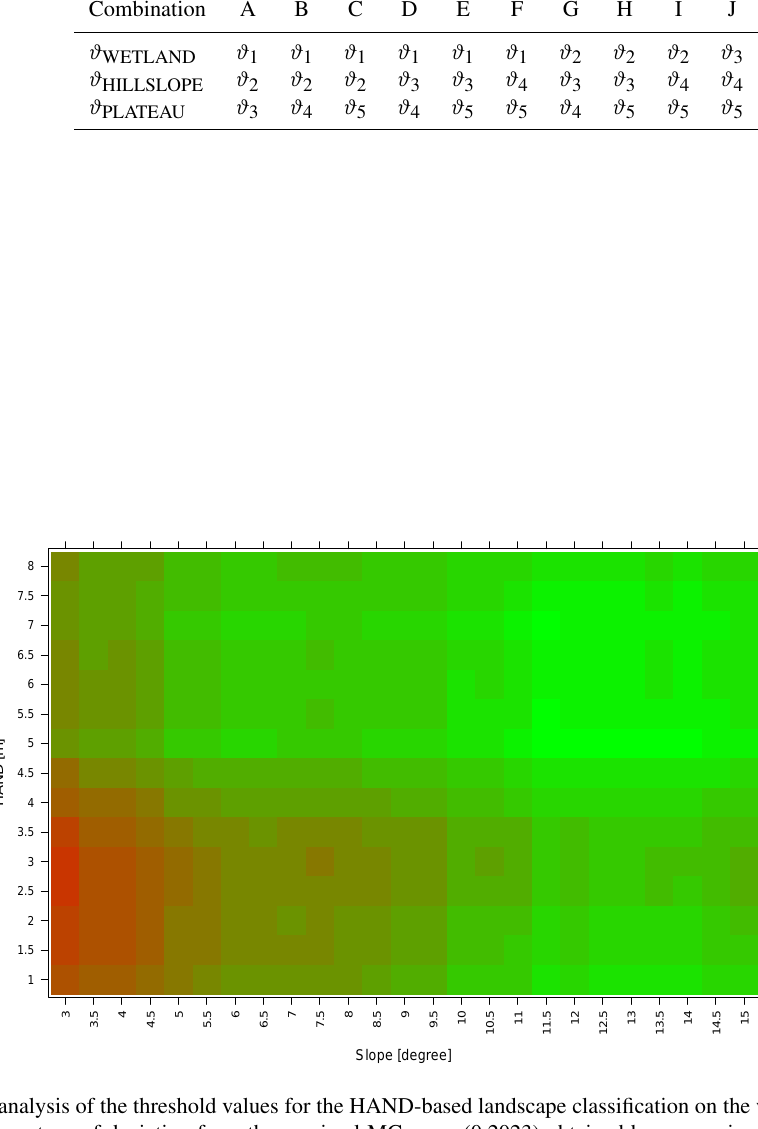
Figure A1. Sensitivity analysis of the threshold values for the HAND-based landscape classification on the whole Reppisch catchment. The level plot shows the percentage of deviation from the maximal MC score (0.2023) obtained by comparing GH11 maps with the reference